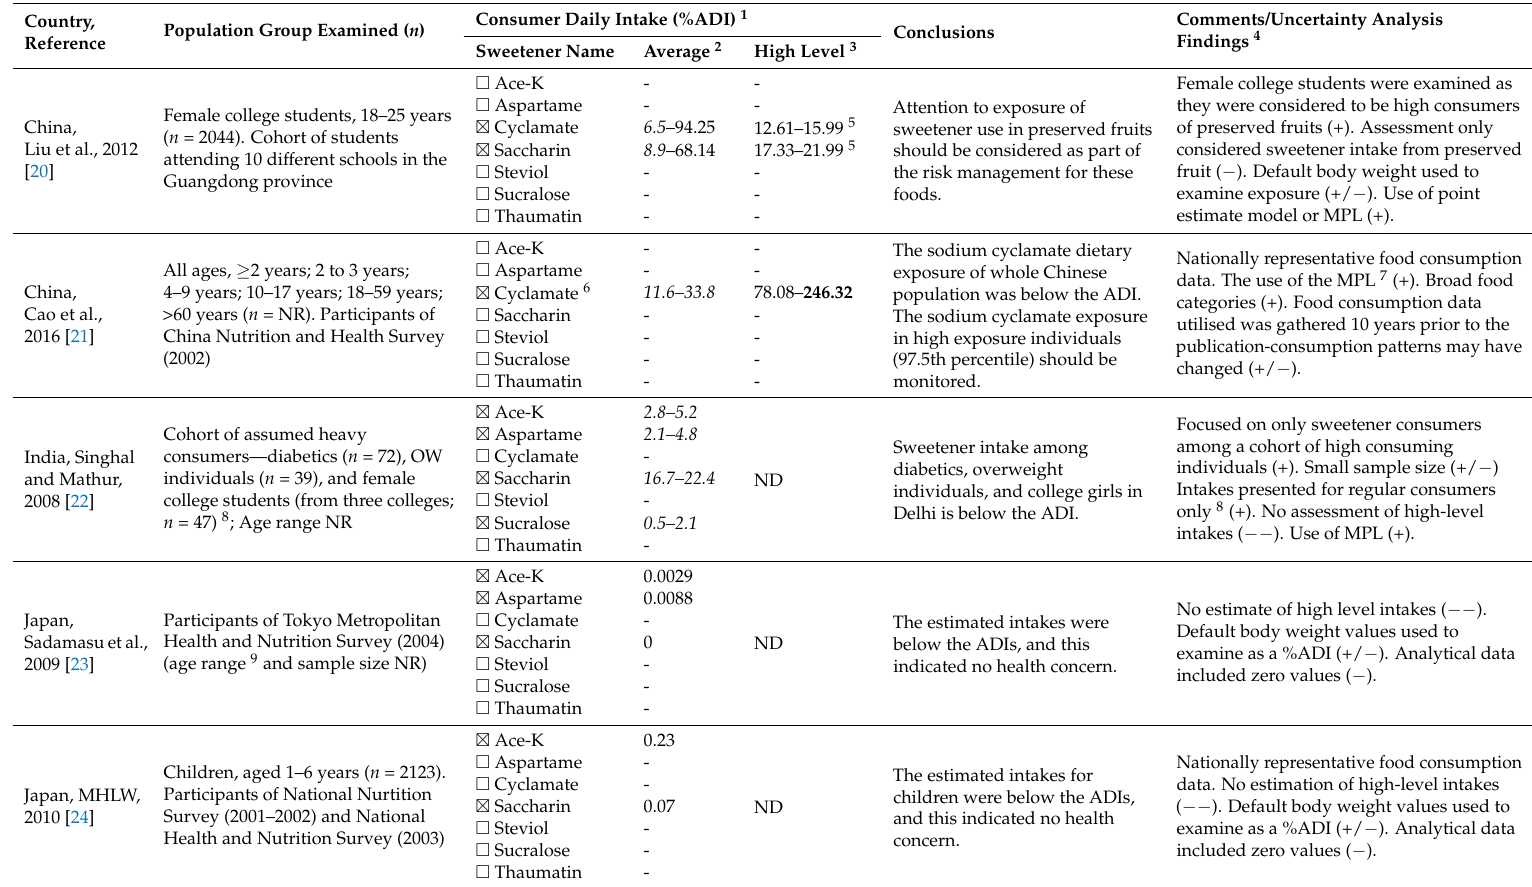
Table 1. Estimated Daily Intakes of Low-/No-Calorie Sweeteners in